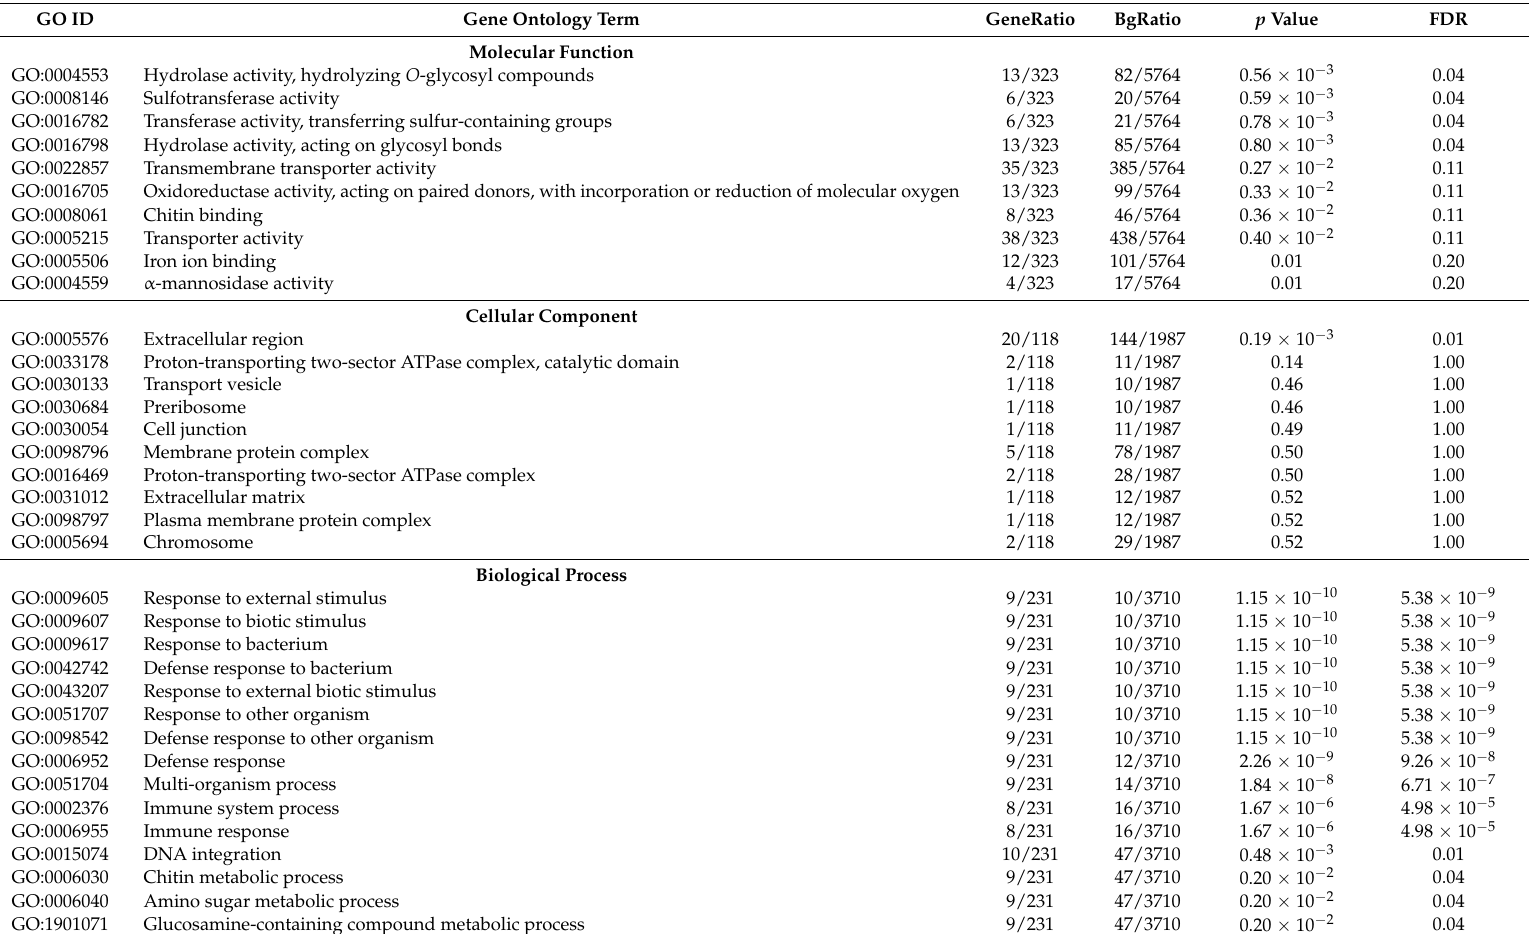
Table 1. GO functional enrichment analysis of DEGs between Dazao and sk